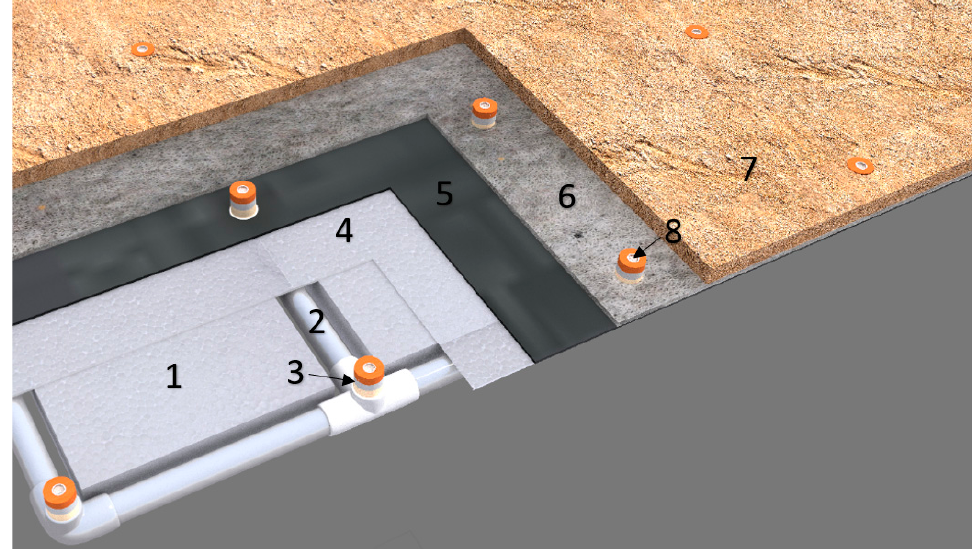
Figure 8. The layers in the novel green roof.